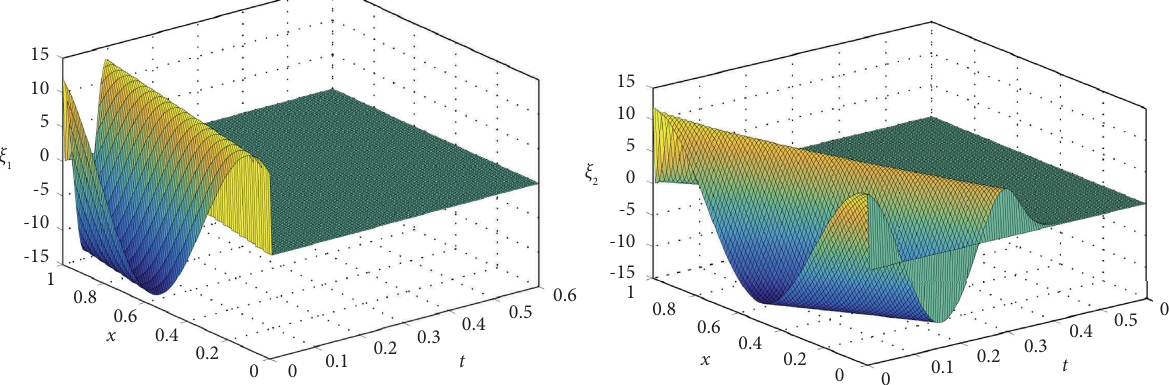
Figure 2: Te convergence of the state ξ